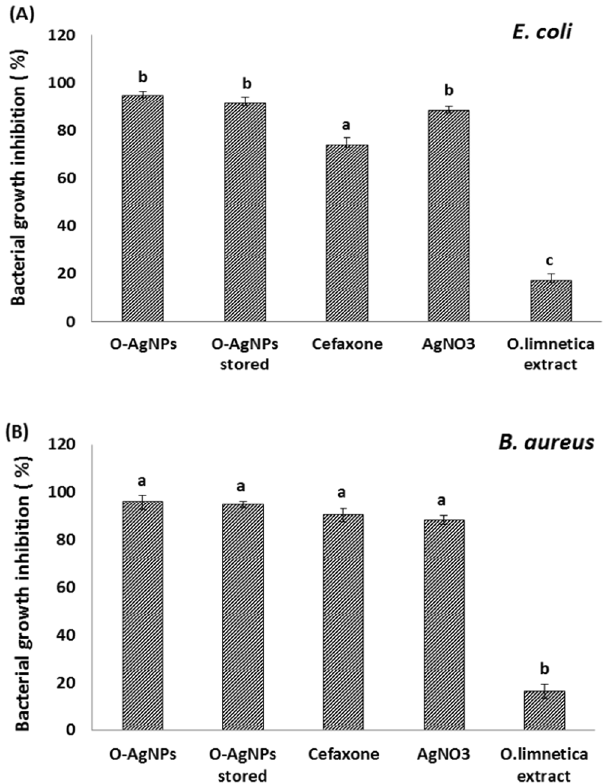
Figure 7. Bacterial growth inhibition (culture optical density) of O-AgNPs against E . coli ( A ) and B . cereus ( B